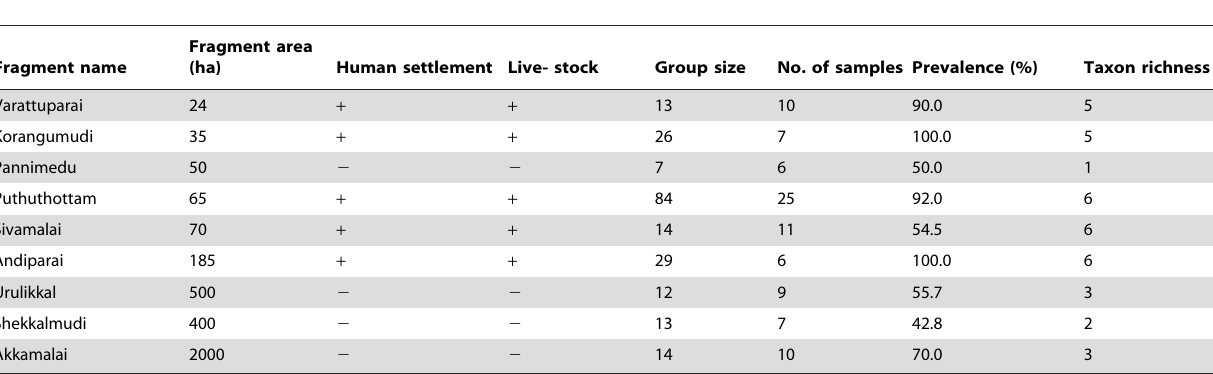
Table 1. Habitat attributes of the nine sampled forest fragments and the prevalence and taxon richness of gastrointestinal parasites in lion-tailed macaque ( + , present; 2 ,